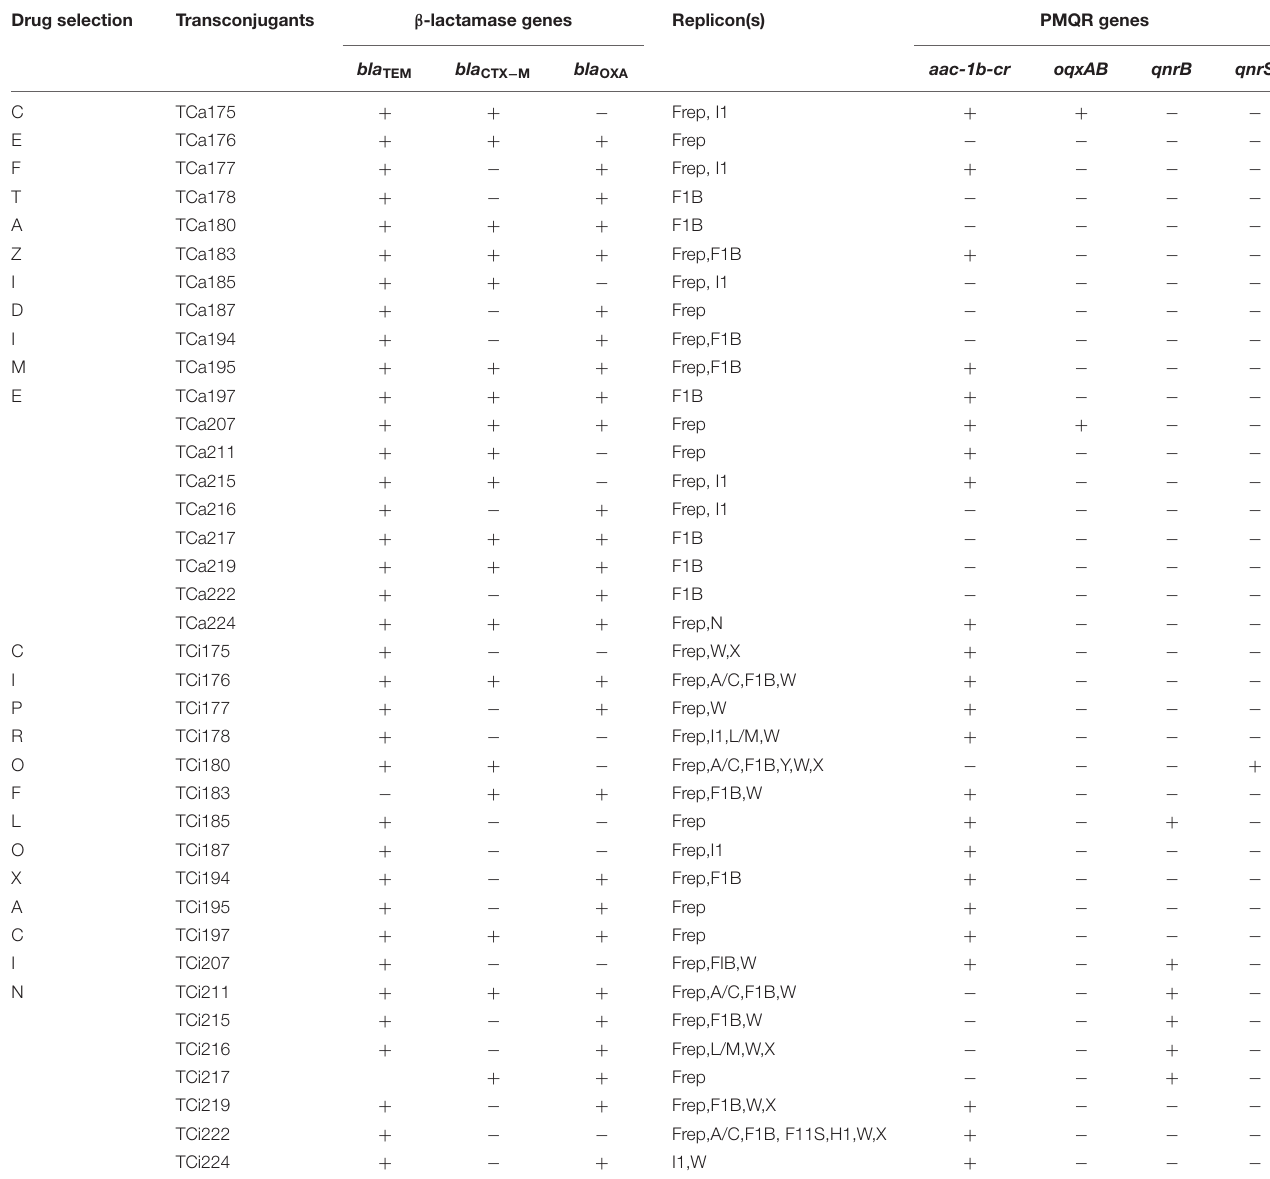
TABLE 3 | Plasmid replicon types and resistance gene distribution among the transconjugants. Drug selection